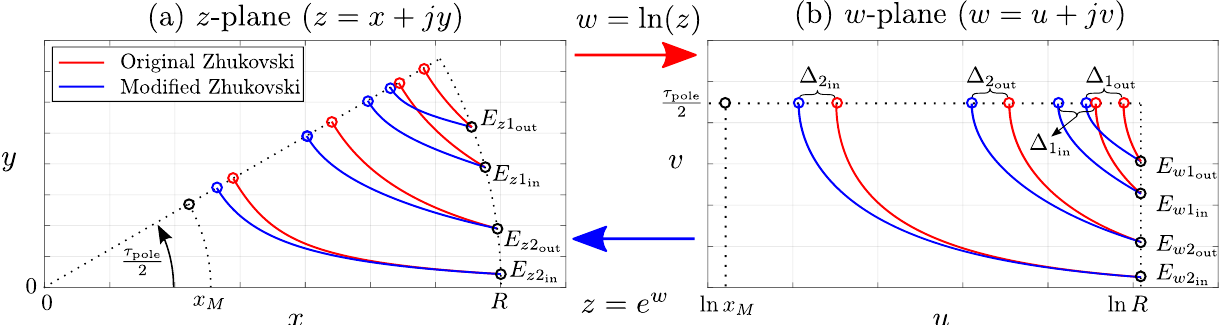
Figure 11. Modification of Zhukovski lines via conformal mapping. Subfigures ( a ) and ( b ) are explained within the Section 5.4 and related